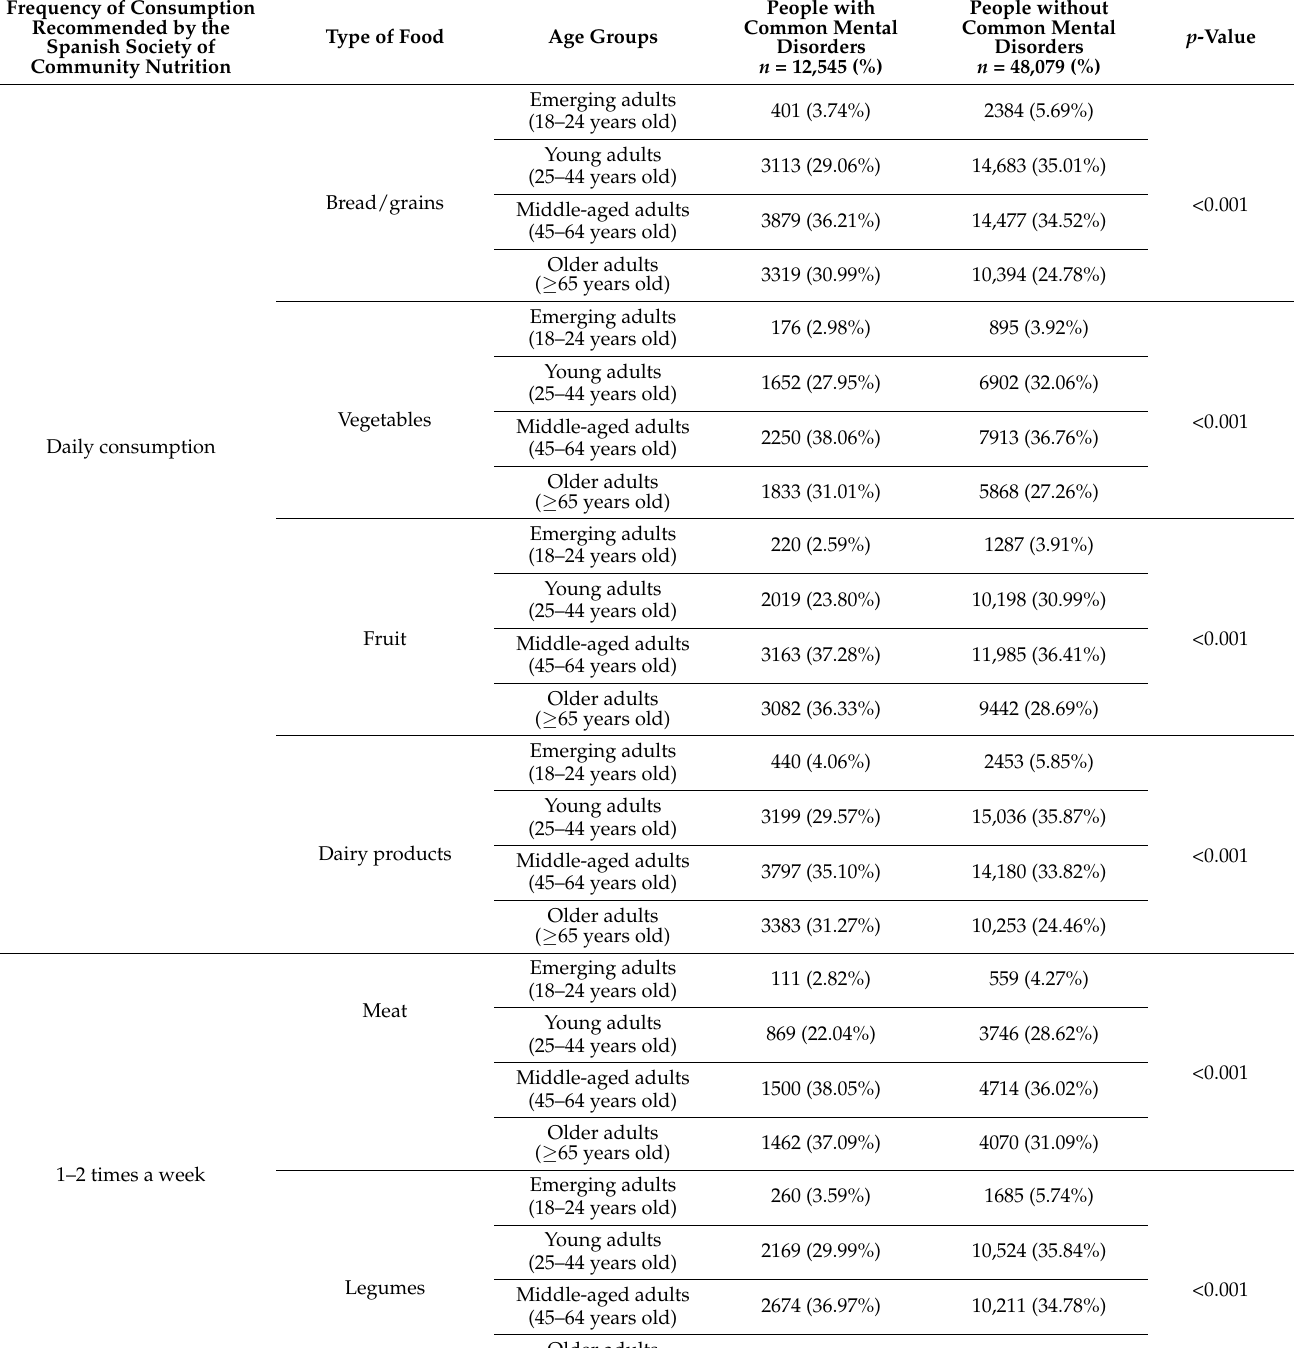
People with Common